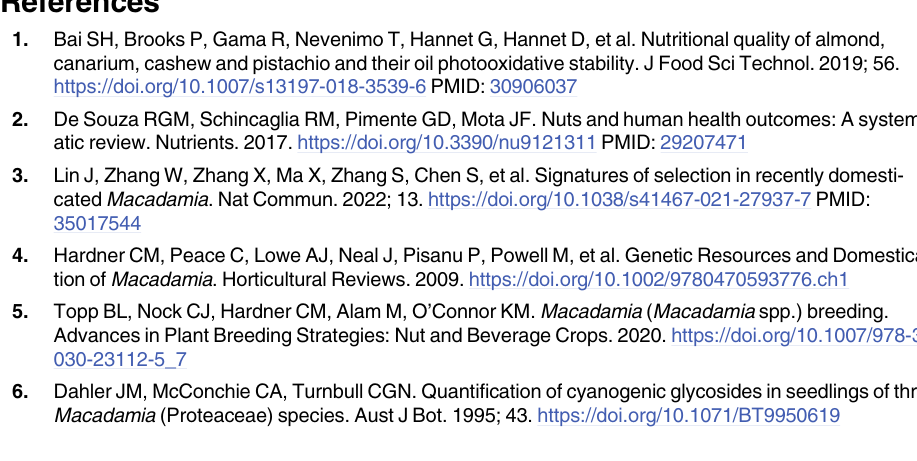
S1 Table. The abbreviations and NCBI accession numbers of mt genomes used in this